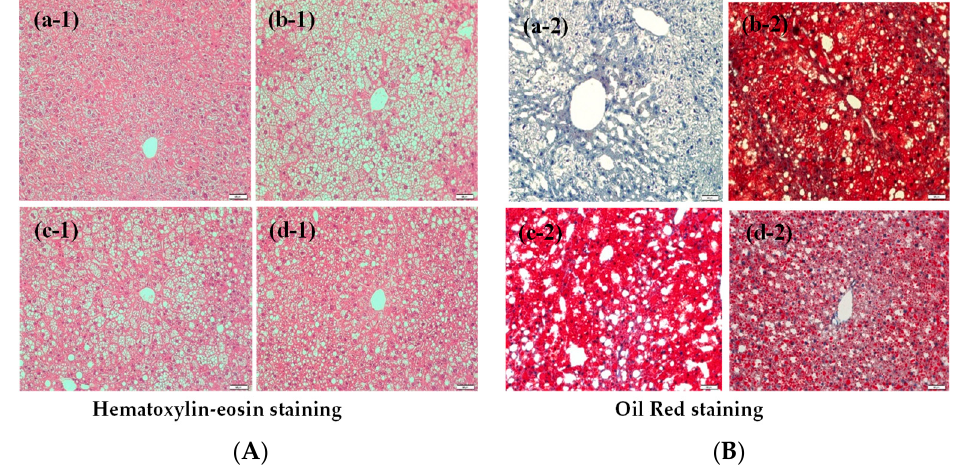
Figure 7. Effects of PL-EA on the hepatic lipogenesis in NAFLD mouse model. Representative photographs of hematoxylin-eosin (H&E) ( A ) and Oil Red O staining ( B ) of mice liver tissues for histological examination. ( a-1 , a-2 ) control. ( B ) ( b-1 , b-2 ) HFD, high-fat/high-fructose diet. ( c-1 , c-2 ) PL-EA-L: HDF + low dose PL-EA (35 mg/kg). ( d-1 , d-2 ) PL-EA-H: HDF + high dose PL-EA (70 mg/kg). Magnification, 200×.